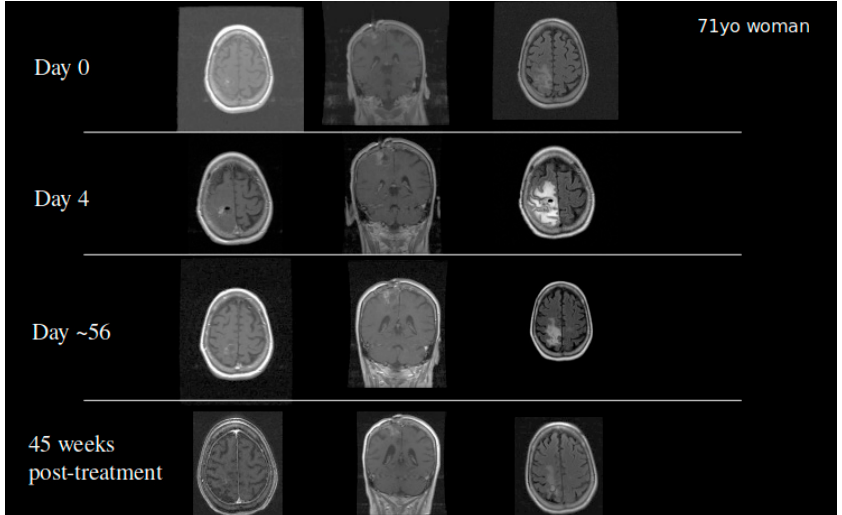
Figure 4. A 71-year-old woman who developed a parietal lobe syndrome on the fourth day of topotecan (TPT) by the CED treatment. Scans are shown at the time of treatment (day 0), at the time the dose limiting toxicity occurred (day 4), 8 weeks after treatment, and 45 weeks after treatment with approximately 90% return to her baseline neurological exam. She was progression free 3 years after the treatment and died just under 4 years post CED.